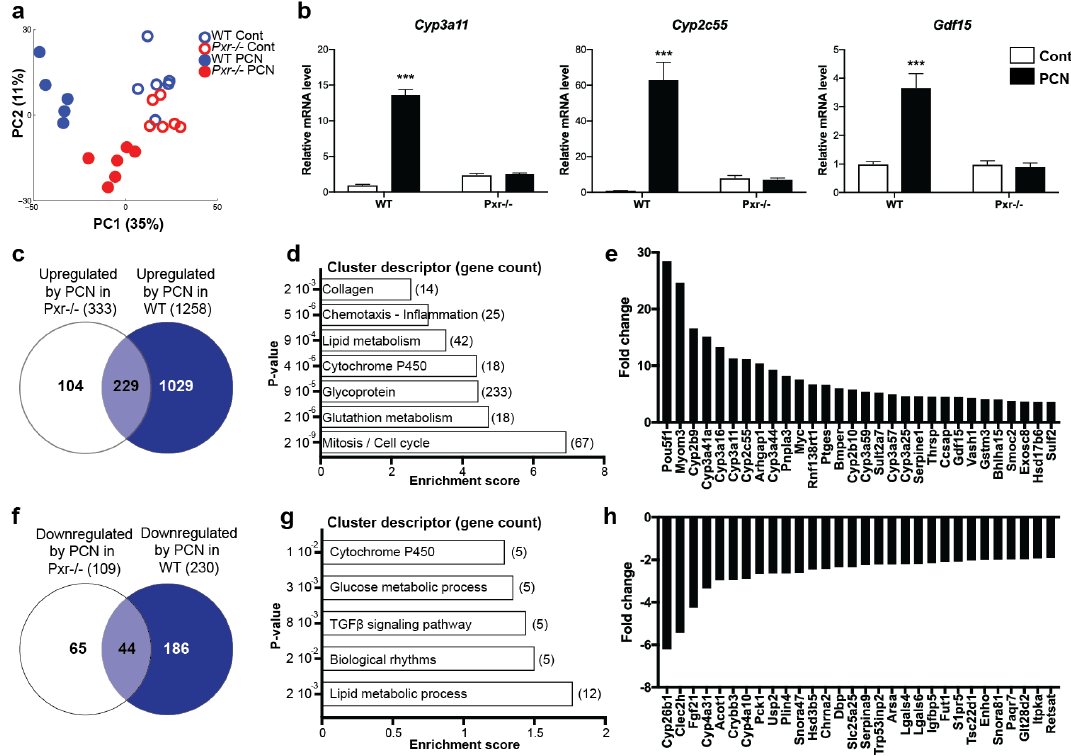
Figure 2. Impact of pregnane X receptor (PXR) activation on the hepatic transcriptome. ( a ) Principal component analysis (PCA) score plots of the whole transcriptomic dataset. ( b ) qPCR confirmation on selected genes. * p ≤ 0.05, ** p ≤ 0.01, *** p ≤ 0.005 for PCN effect using 2-way ANOVA and Tukey’s post-tests. ( c , f ) Venn diagram representing the number of genes affected by PCN treatment. ( d , g ) Gene enrichment analyses of the PXR-target genes. ( e , h ) The 30 genes with the highest fold-changes upon PCN treatment.